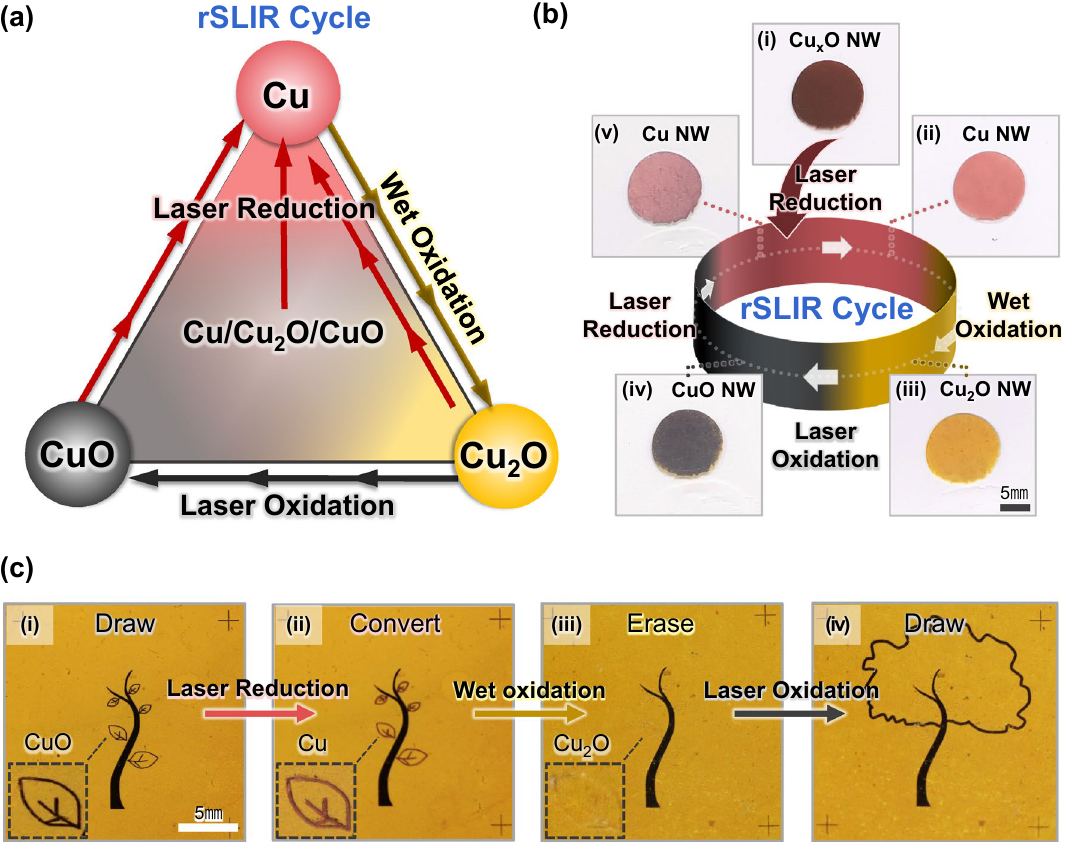
Fig. 3 a A process diagram of rSLIR cycle; the arrows connect the reactive substance and the produced substance. b An optical image of rSLIR on the Cu X ONW network. i Prepared Cu x ONW network oxidized at 200 °C for 30 min. ii The first laser reduced CuNW. iii Wet-oxidized Cu 2 ONW. iv Laser-oxidized CuONW. v The second laser-reduced CuNW (laser oxidation, laser reduction conditions: 125 mW, 10 mm s −1 , scale bar: 5 mm). c An optical image of rSLIR on the prepared pattern. i Yellow Cu 2 ONW with black CuONW tree pattern, and the inset opti- cal image is a magnified black CuONW leaf. ii The leaves are converted to red CuNW through laser reduction. iii Removal of the pattern by wet oxidation. iv The new pattern is added to the existing pattern through laser oxidation (laser oxidation, laser reduction conditions: 125 mW, 10 mm s −1 , scale bar: 5